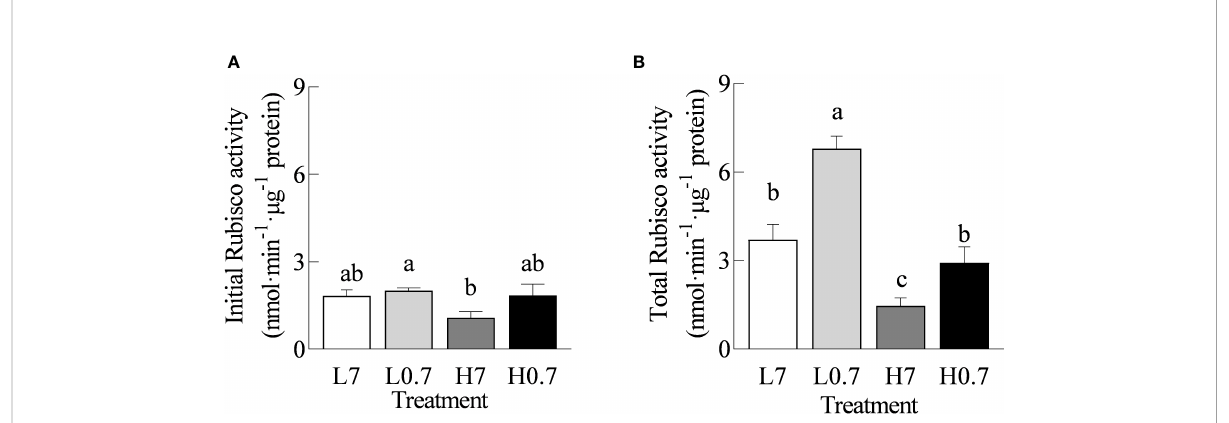
FIGURE 5 Effect of R/FR on Rubisco activity in cucumber leaves under salt stress. (A) , Initial Rubisco activity; (B) , Total Rubisco activity. Different letters indicate signi fi cant differences (P< 0.05; n=